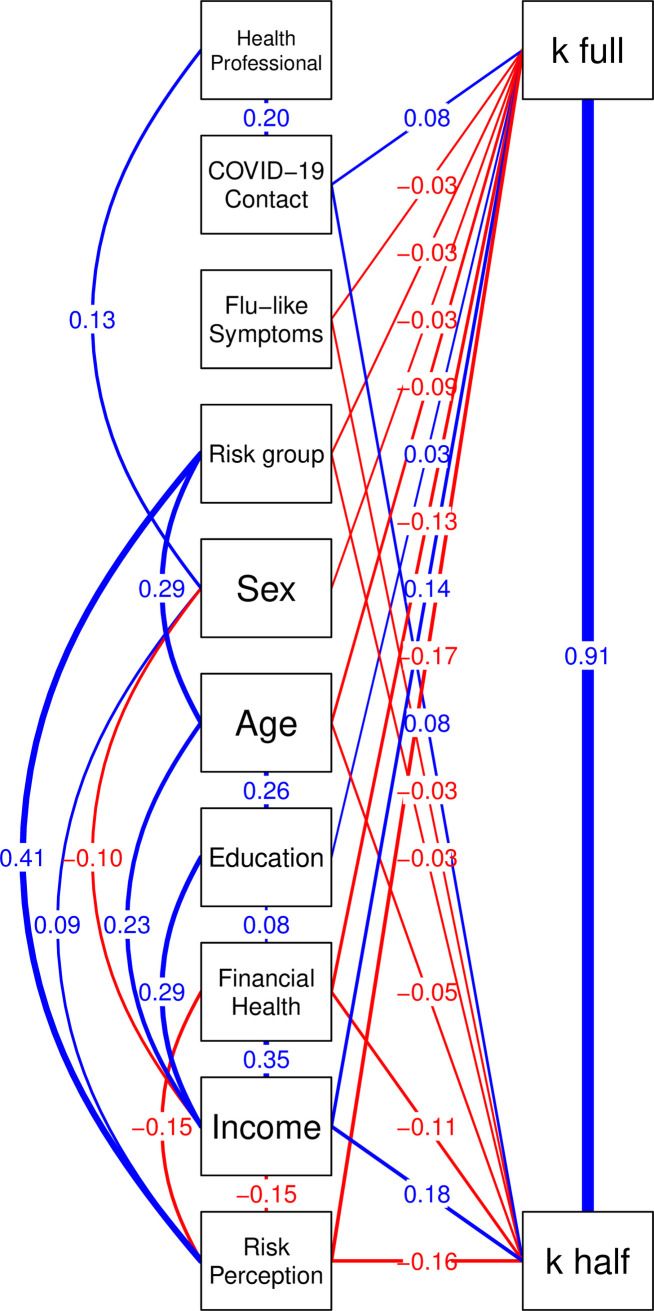
Structural Equation Model (SEM).All the significant parameter estimates were standardized so they can be interpreted with reference to other parameters in the model and relative strength of pathways within the model.